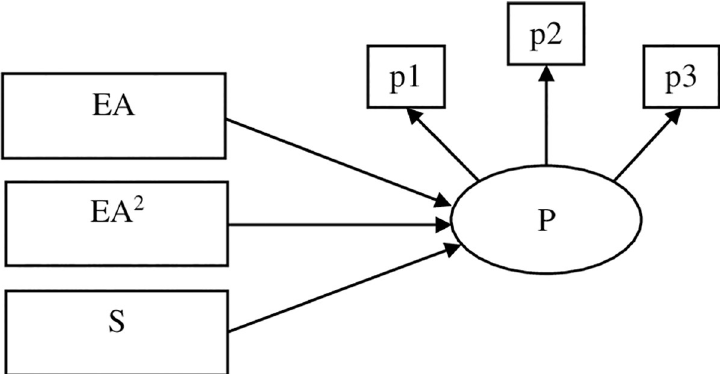
Fig 1. The conceptual diagram for the test of linear and quadratic effects of early adversity on personality traits. P = personality traits; EA = early adversity; S = adulthood stressor exposure; p1-p3 represents manifest indicators of